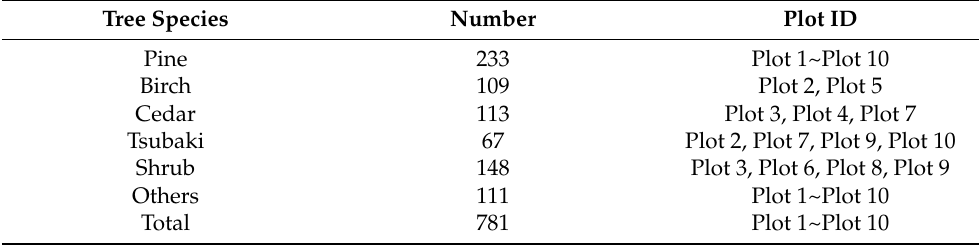
Table 2. Tree species information for ten